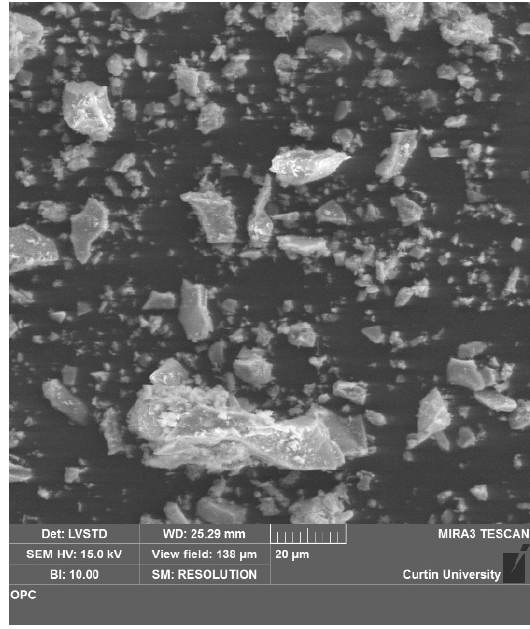
Figure 1. SEM micrograph of the OPC.